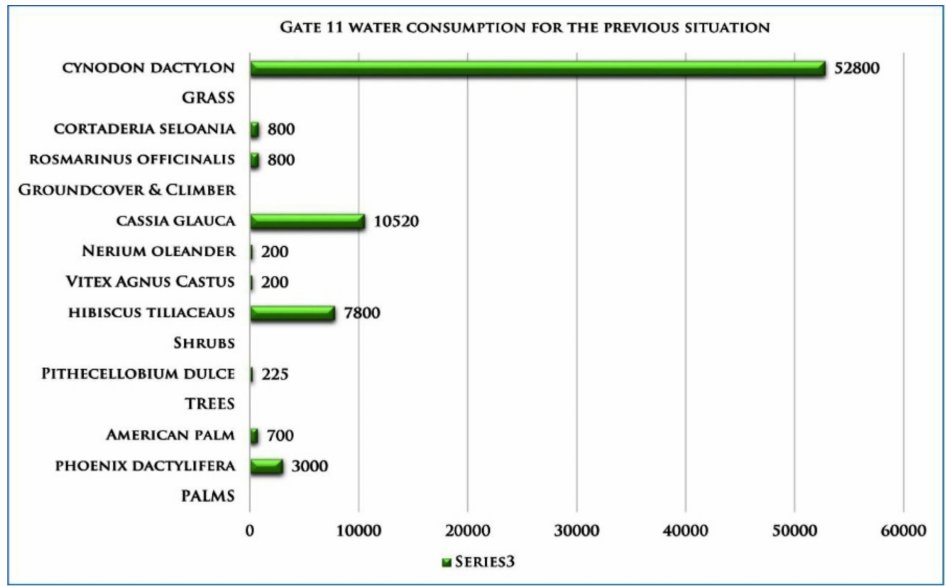
Figure 17. Experiment 3 water consumption quantity for the previous status. Previous tender softscape design water consumption (Details in Table A3).